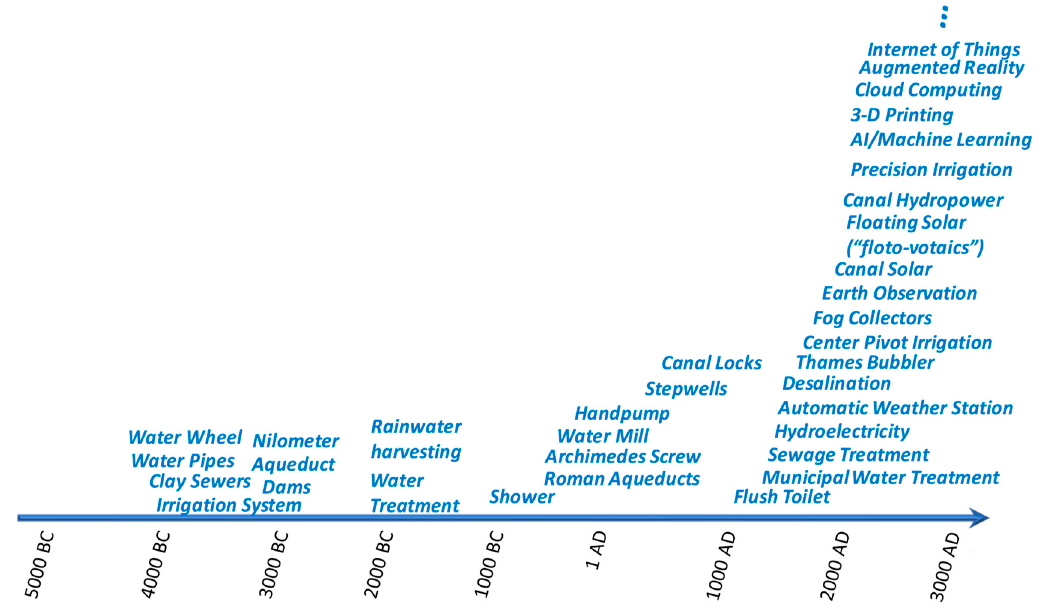
Figure 2. Timeline of water technology evolution.